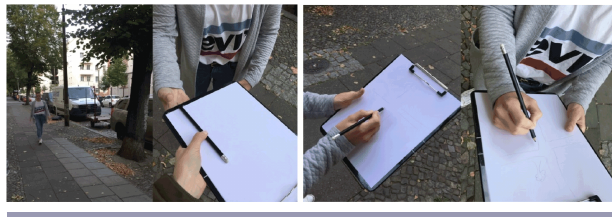
Fig. 3 . Mental mapping exercise design in the field (own